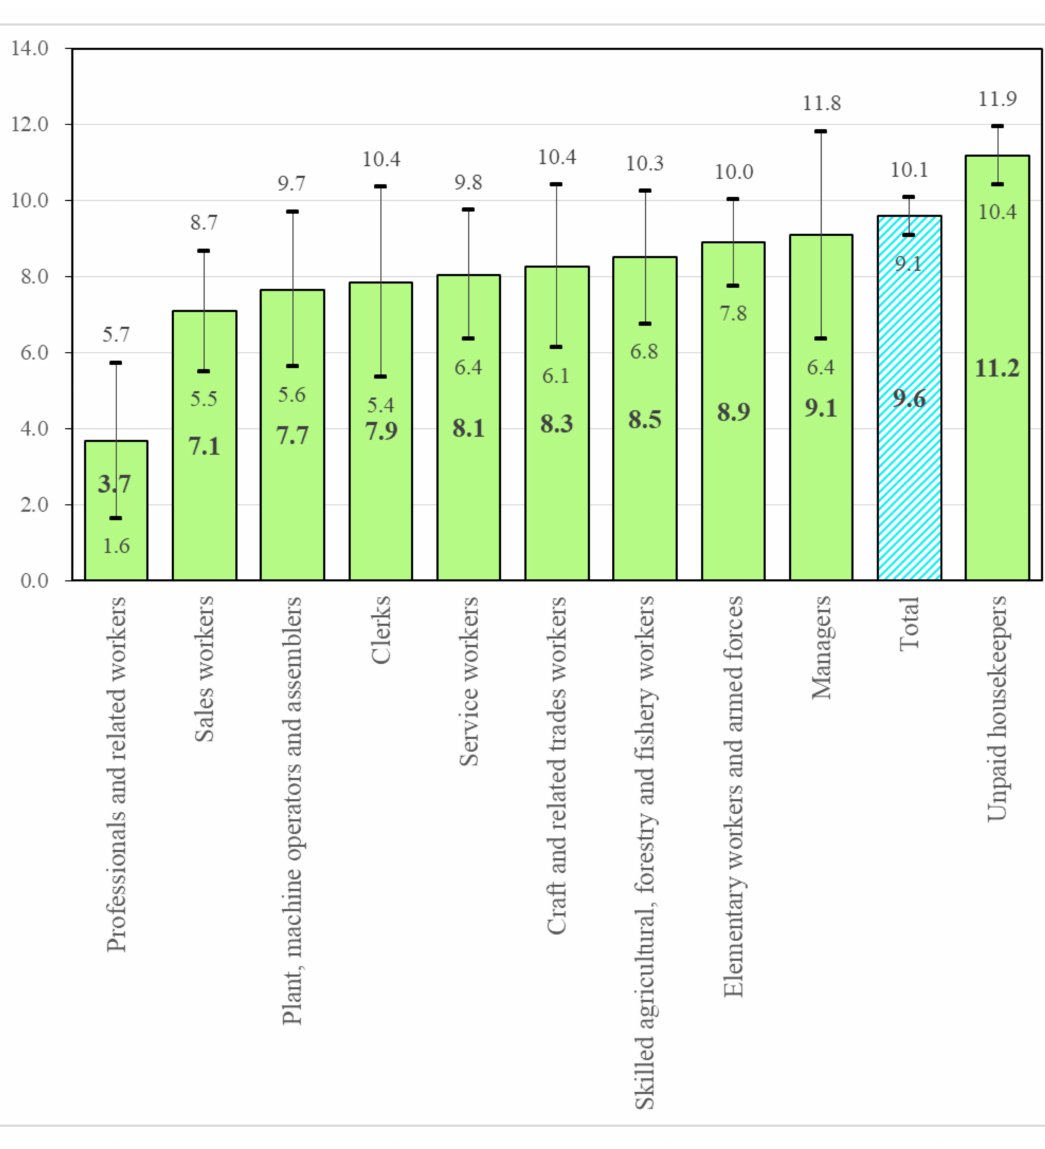
Figure 1. Predicted probability (%) and its 95% confidence interval of cognitive impairment by occupation